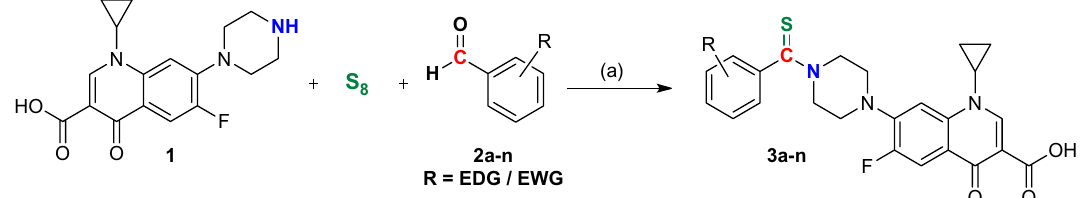
Figure 2. Outline for the synthesis of N- thioacylated ciprofloxacin derivatives 3a–n . Reagents and conditions: (a) DMSO, 50 °C, 4–8